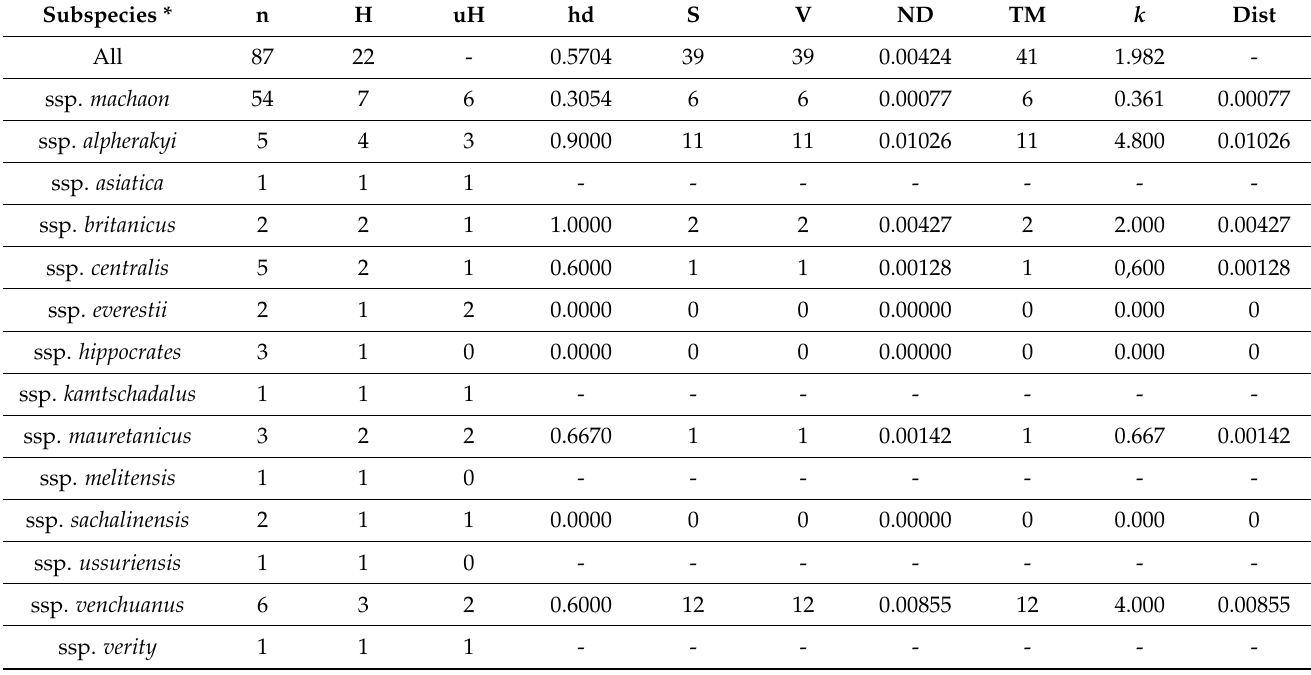
Table 1. Standard genetic indices and average pairwise genetic distance of 16S rDNA marker.